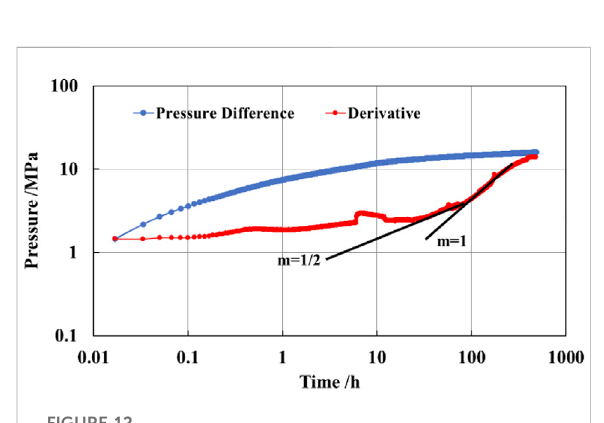
FIGURE 12 Log – log curves of pressure difference and the derivative.